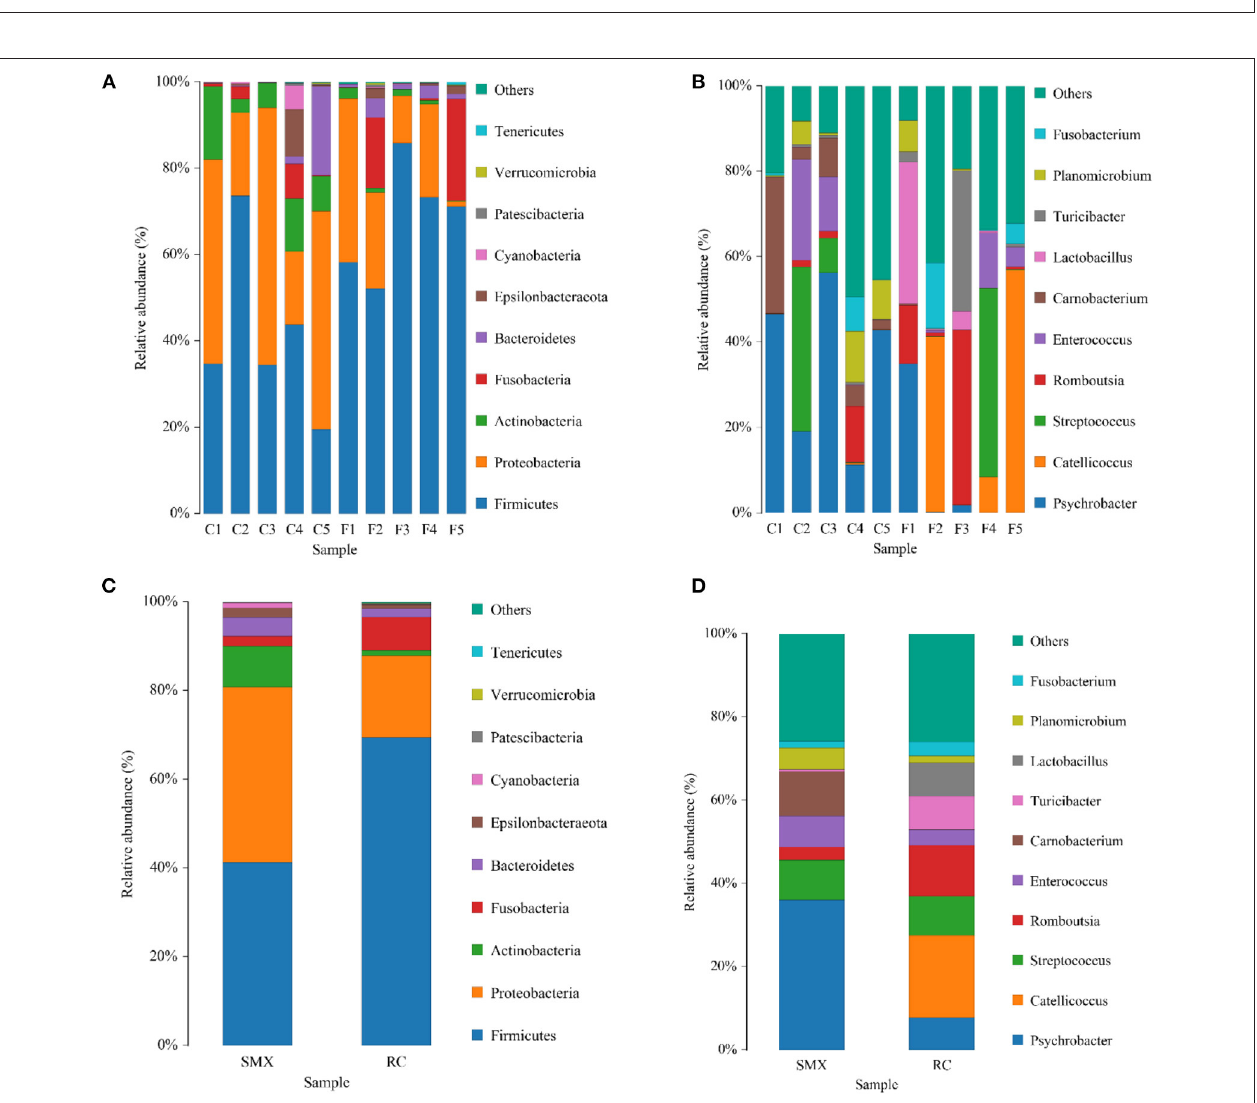
FIGURE 4 | Bar chart of relative abundance. Relative abundance (%) of the 10 most abundant bacteria phyla ( A for individuals and C for groups) and genera ( B for individuals and D for groups) obtained from 10 fecal samples of whooper swans at two study sites. Others, Bacteria taxa with ≤ 1% abundance; Unclassified, sequences that could not be classified (SMX: C1–C5; RC: F1–F5).